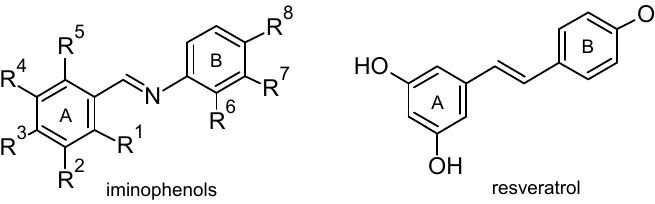
Figure 1. Structure of resveratrol and studied Hydroxyphenyliminomethyl)phenols.